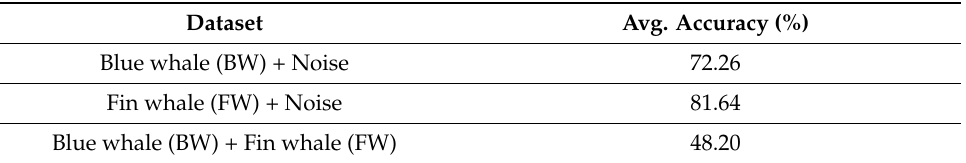
Table 9. The average accuracies (%) obtained by comparison method II based on the Scattergram and CNN